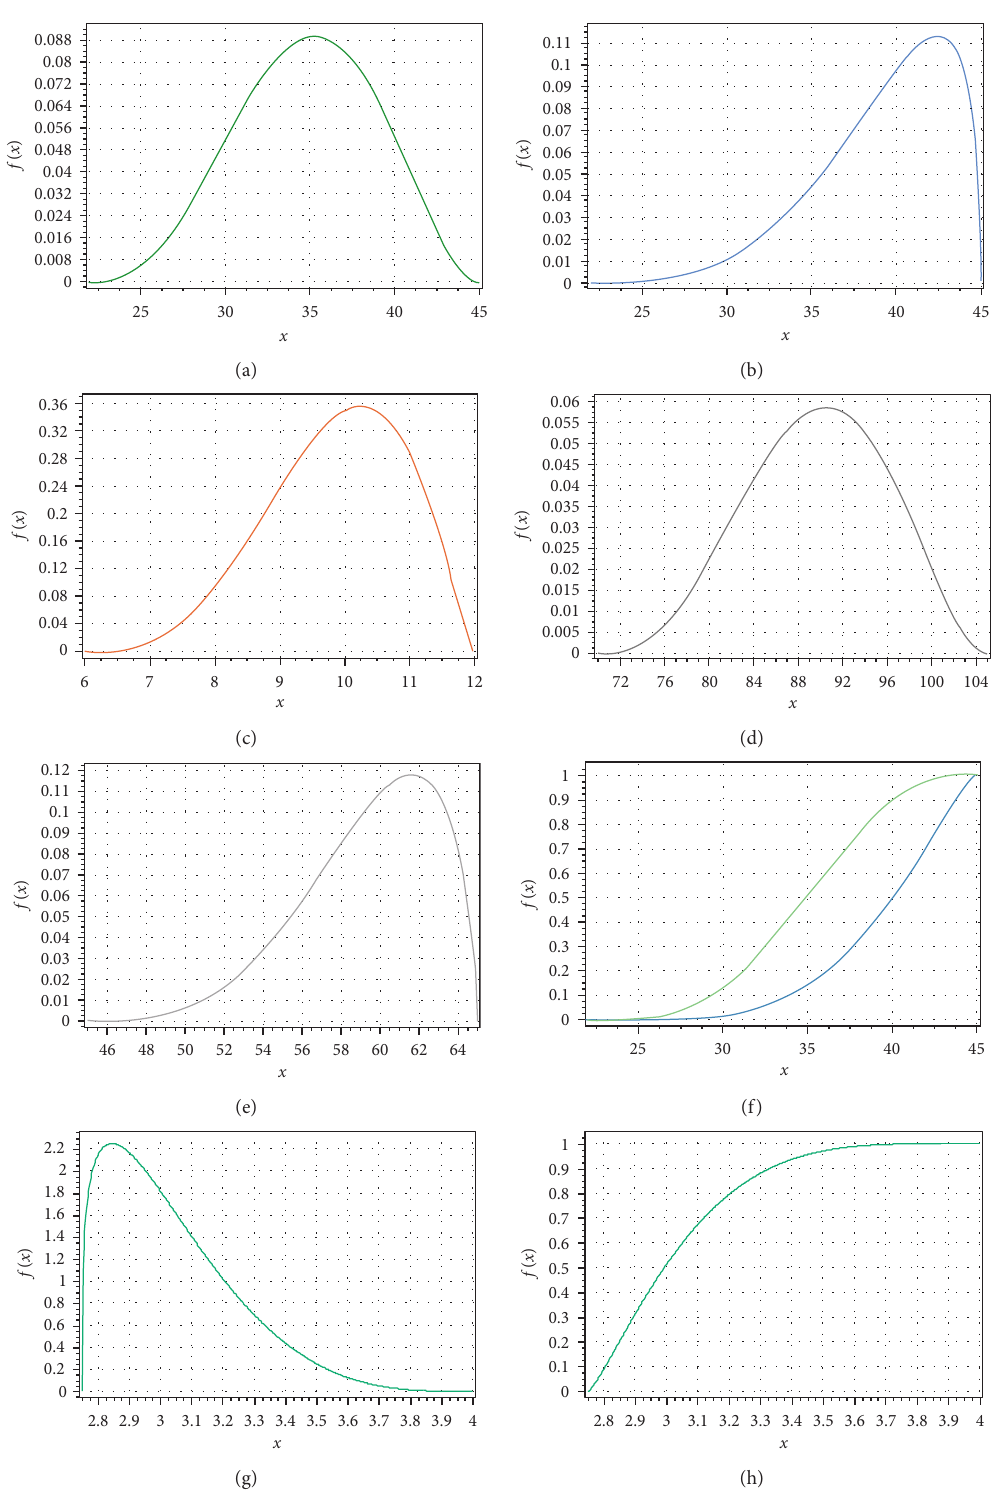
Figure 4: Examples of beta BDF and CDF for travelling and advising times. (a) BDF for t (e) BDF for t 0,5 ; (f) CDF for t 0,1 and t 0,2 ; (g) BDF for t 1 ; (h) CDF for t 1